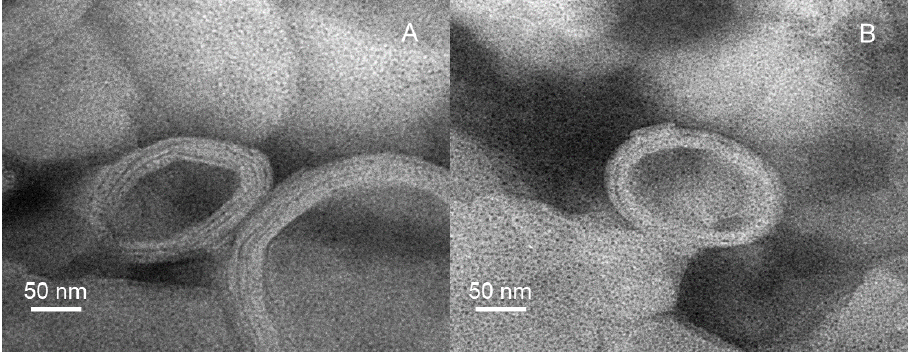
Figure 5. TEM images of Mel-Lip ( A ) and Mel-HA-Lip ( B ).